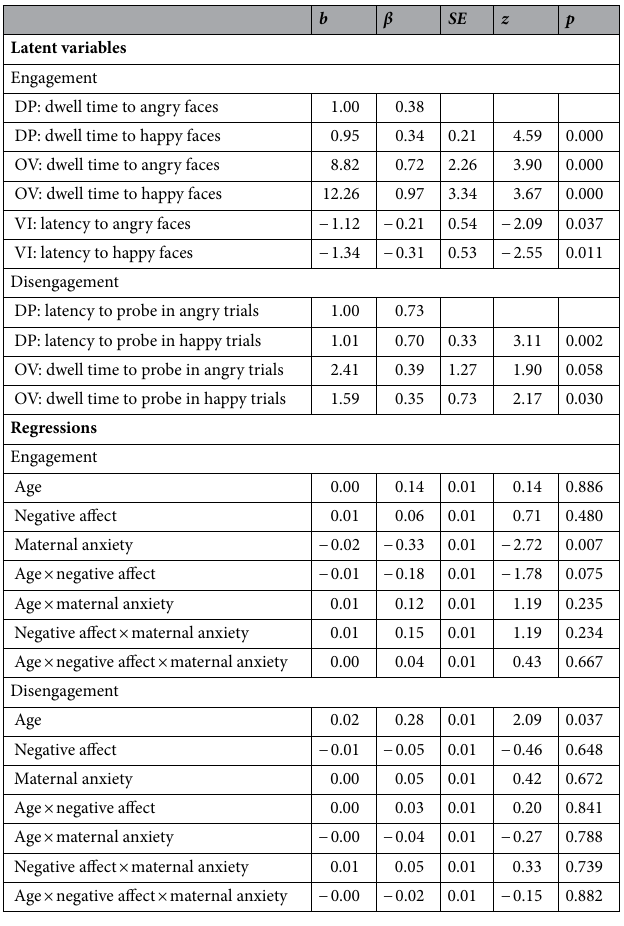
Table 4. Structural equation model assessing relations between age, negative affect, maternal anxiety and the engagement and disengagement factors. N = 193; SE = Standard Error; RMSEA = 0.03; SRMR = 0.07.